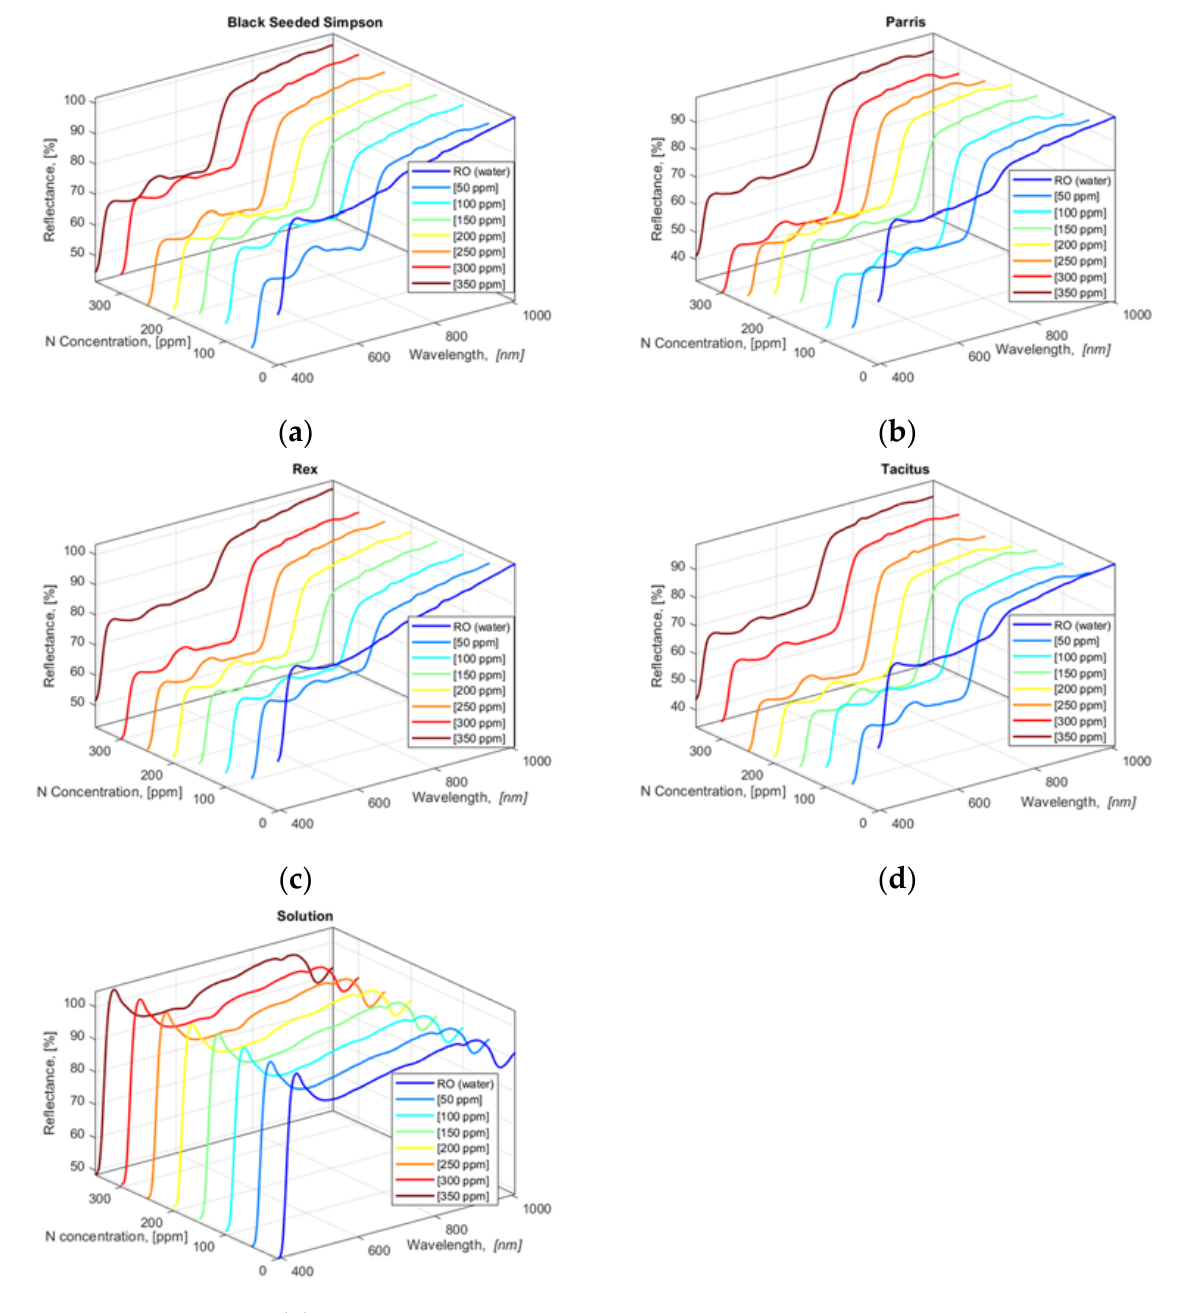
Figure 3. Averaged and smoothed reflectance values of HSI pixel values of four freshly cut lettuce cultivars: ( a ) Black Seeded Simpson, ( b ) Parris, ( c ) Rex RZ, and ( d ) Tacitus and ( e ) solution in hydroponic tubs with different N concentrations.